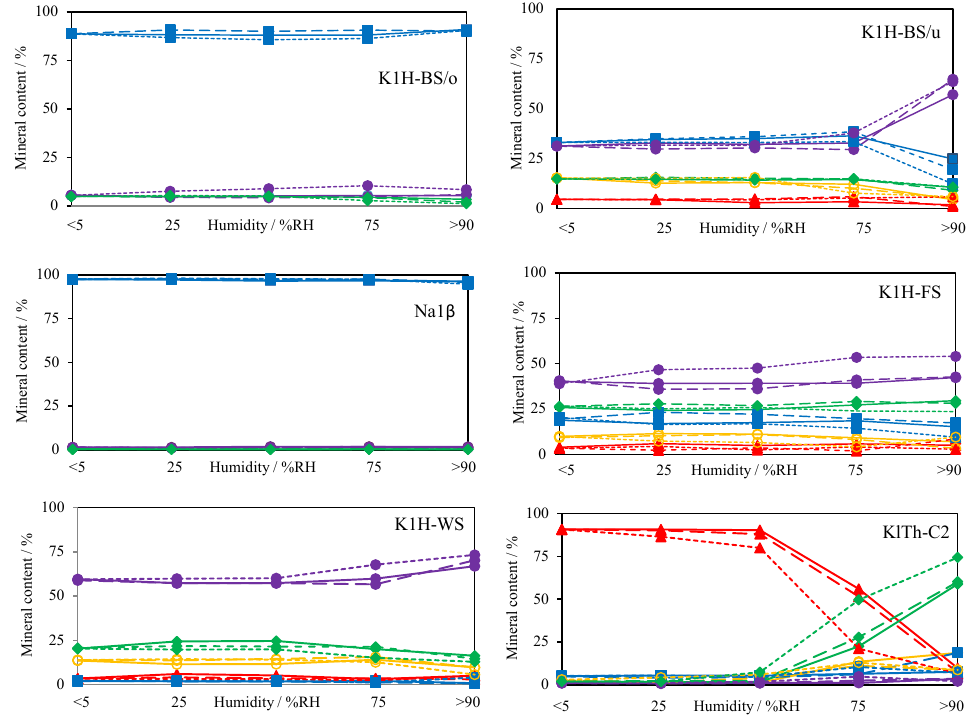
Figure 4. Changes of mineral content (blue squares – halite, red triangles – carnallite, yellow circles – kainite, violet dots – kieserite, green diamonds – sylvite) with increasing humidity. X-ray measurements were performed at < 5%RH, 25%RH, 50%RH, 75%RH and > 90%RH. The same experiment was performed with different gases: solid line, dashed line and dotted line indicate N 2 , CH 4 and CO 2 atmosphere, respectively.